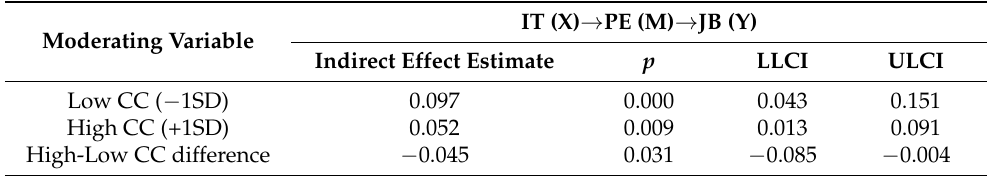
Table 5. The testing results of the moderated mediation effect.